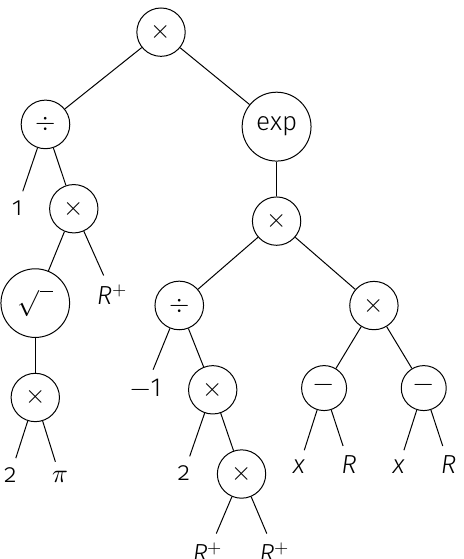
Figure 1. Tree representation of the normal distribution